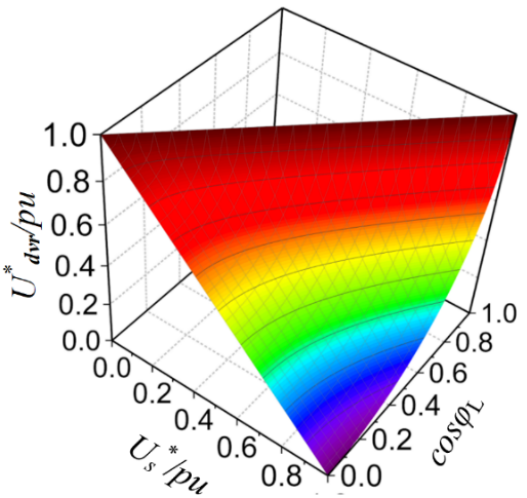
Figure 9. Quantitative analysis of compensation voltage for integrated energy compensation with U s < U r cos φ . L